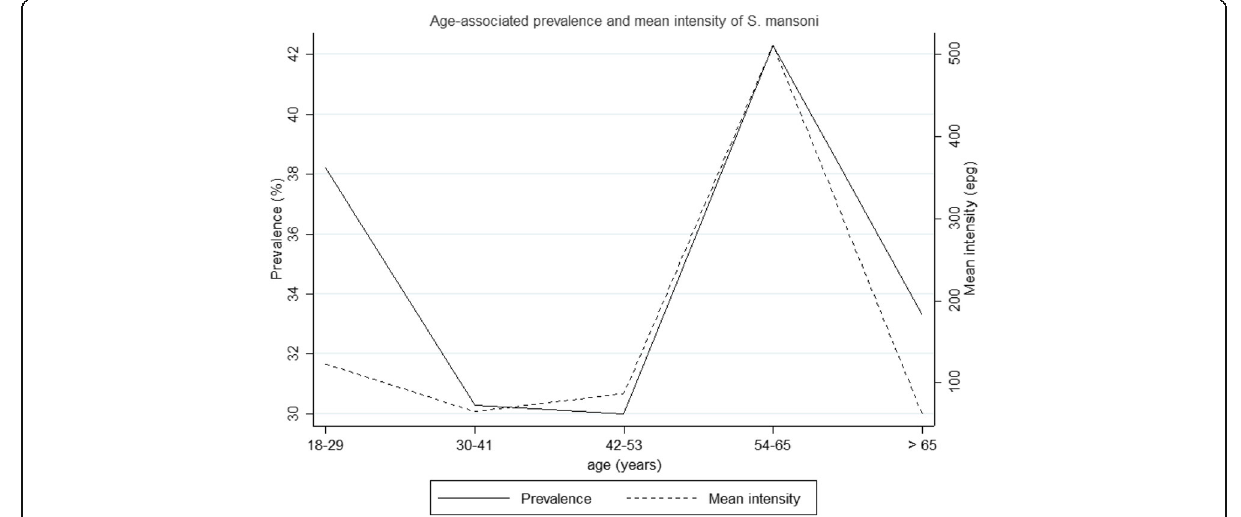
Fig. 2 Age-associated prevalence and mean intensity of S. mansoni